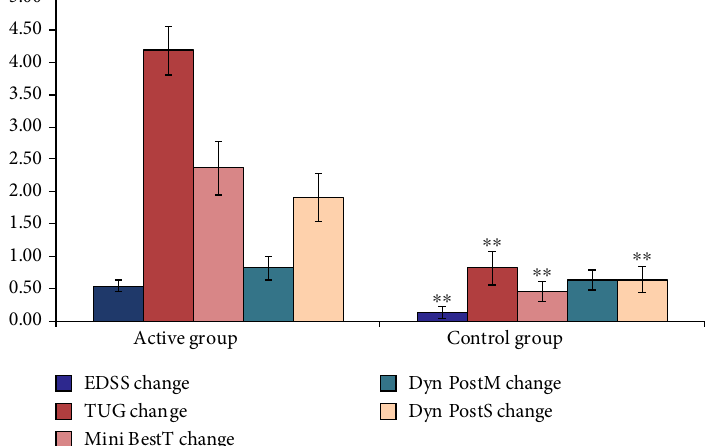
Figure 3: Comparison between moderate active group and moderate control group as regard to all the studied variables. SD: standard deviation; ∗ P < 0 : 05 between group comparison; ∗∗ P < 0 : 01